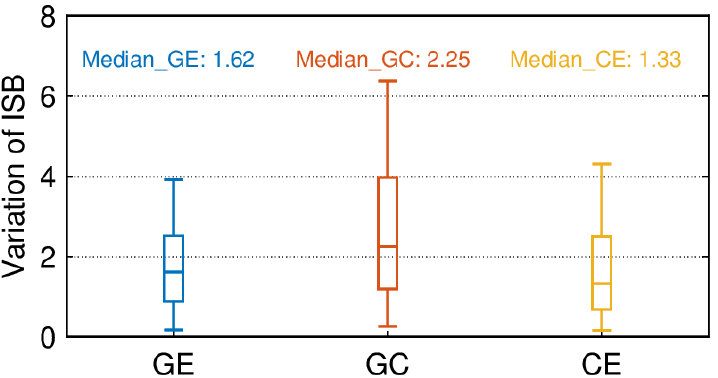
Figure 21. Boxplot of variation of ISB for two days adjacent to all tracking stations (1 February 2022 to 28 February 2022).